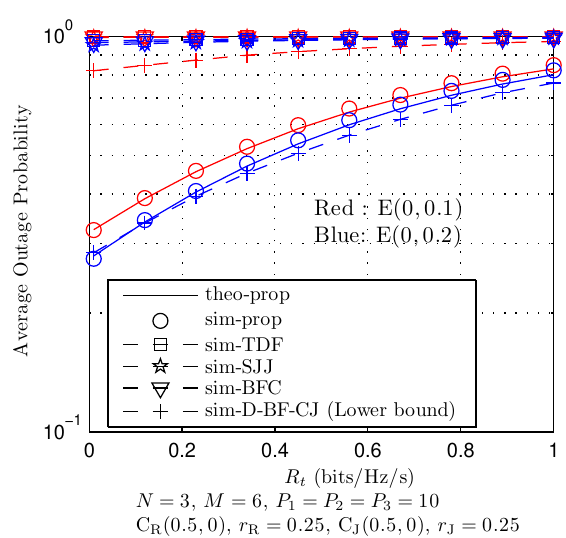
Figure 5. Outage performance in relation to the changes in the target transmission rate R . M = 6 , N = 3 . t